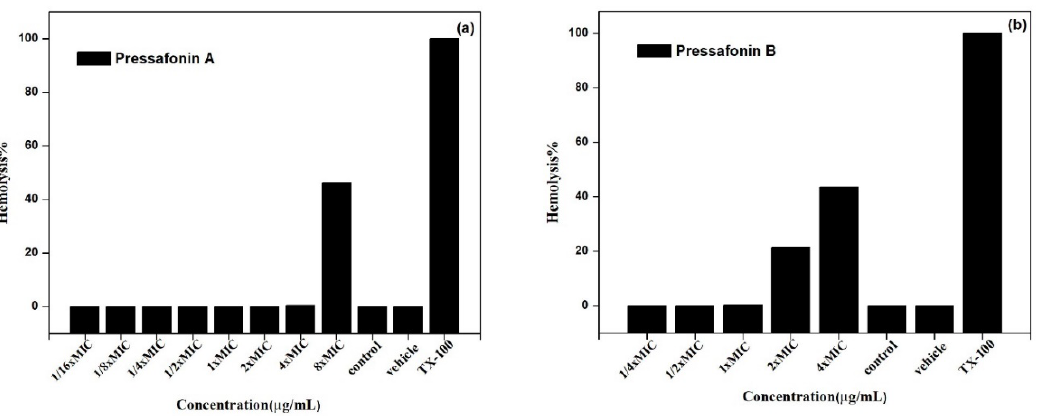
Figure 5. Percentage of hemolysis by 6 ( a ) and 7 ( b ) at different concentrations. Control: 50 μL of RBCs suspension (5%), vehicle: 1× PBS. All experiments were repeated three times.